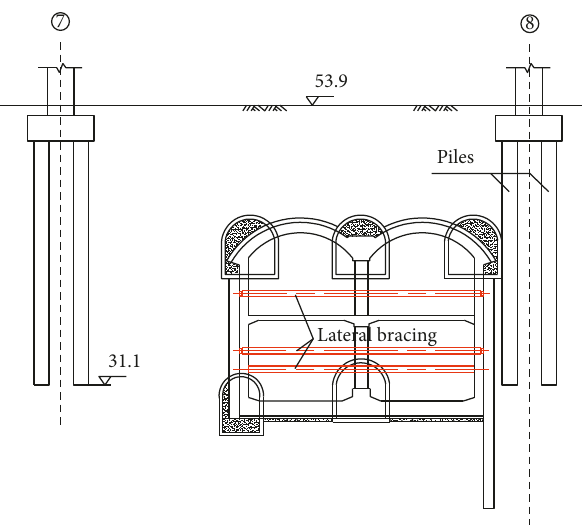
Figure 7: Lateral bracing and isolation pile (unit: